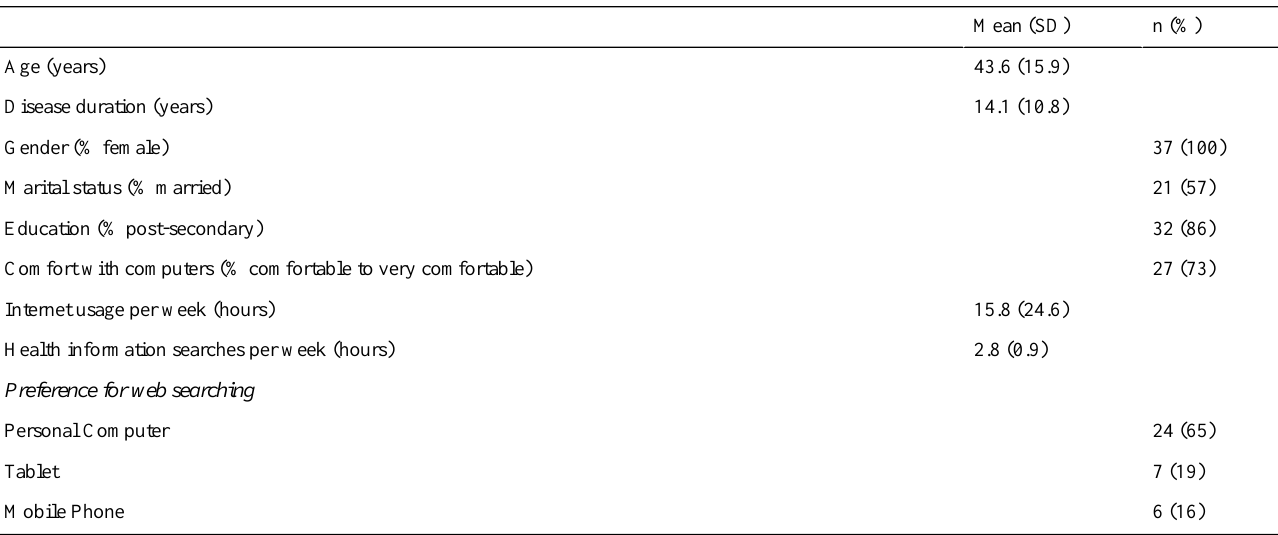
Table 2. Participant characteristics (N=37).